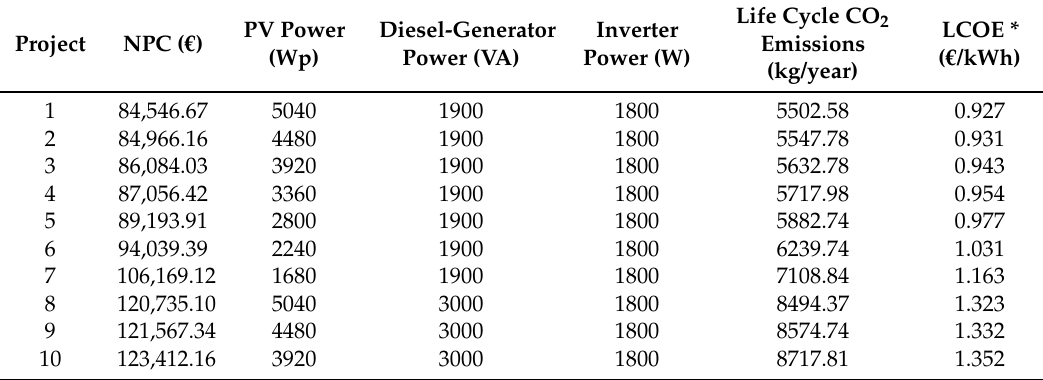
Table 3. Main results of the best combinations given by iHOGA solar PV +